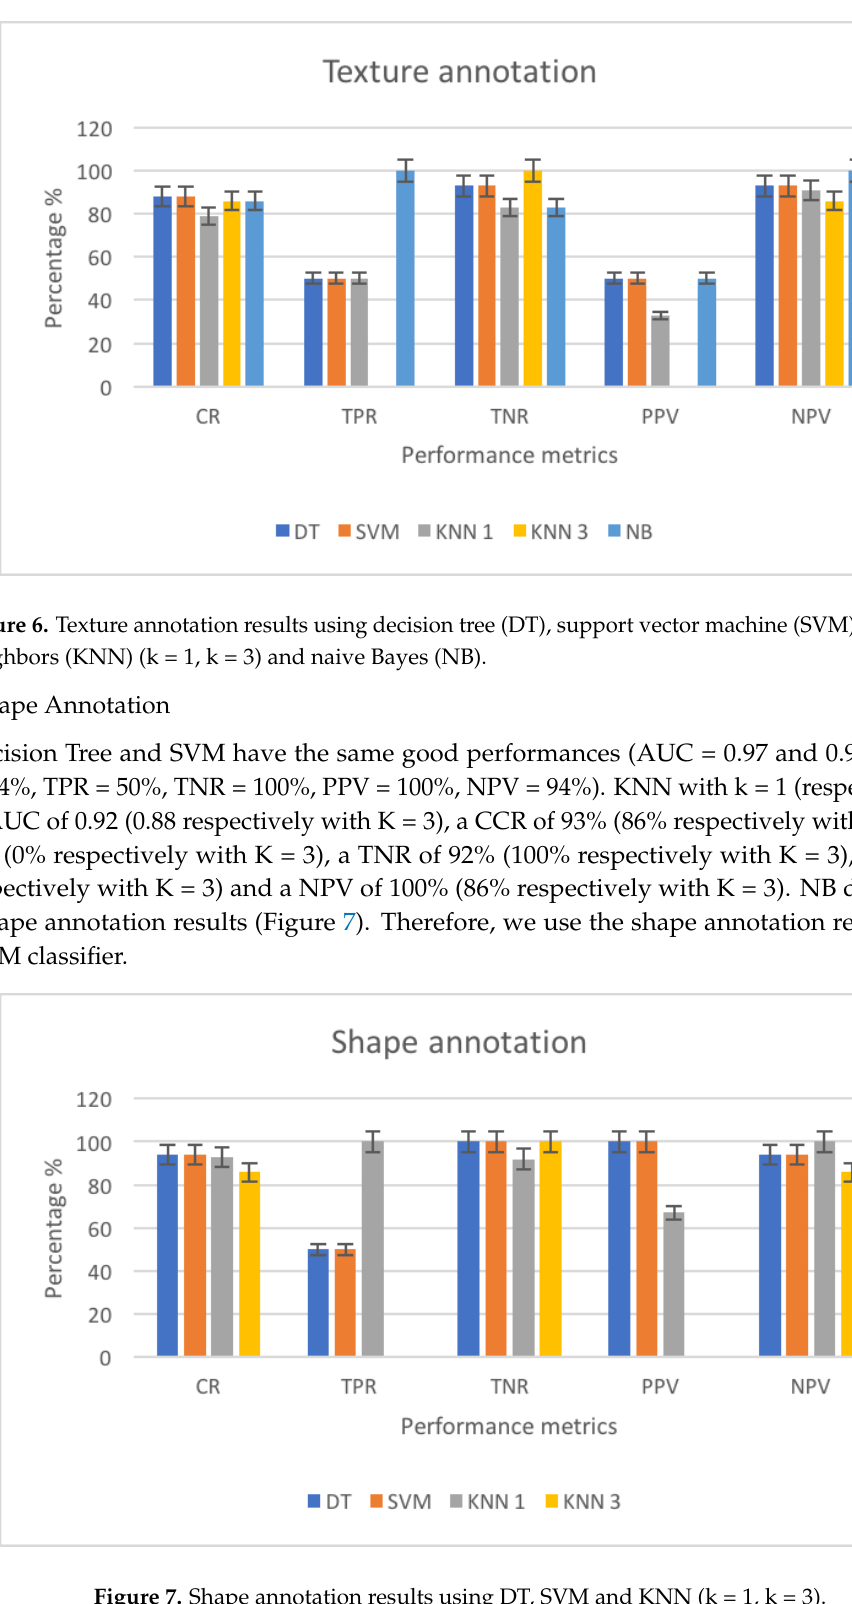
Figure 7. Shape annotation results using DT, SVM and KNN (k = 1, k =